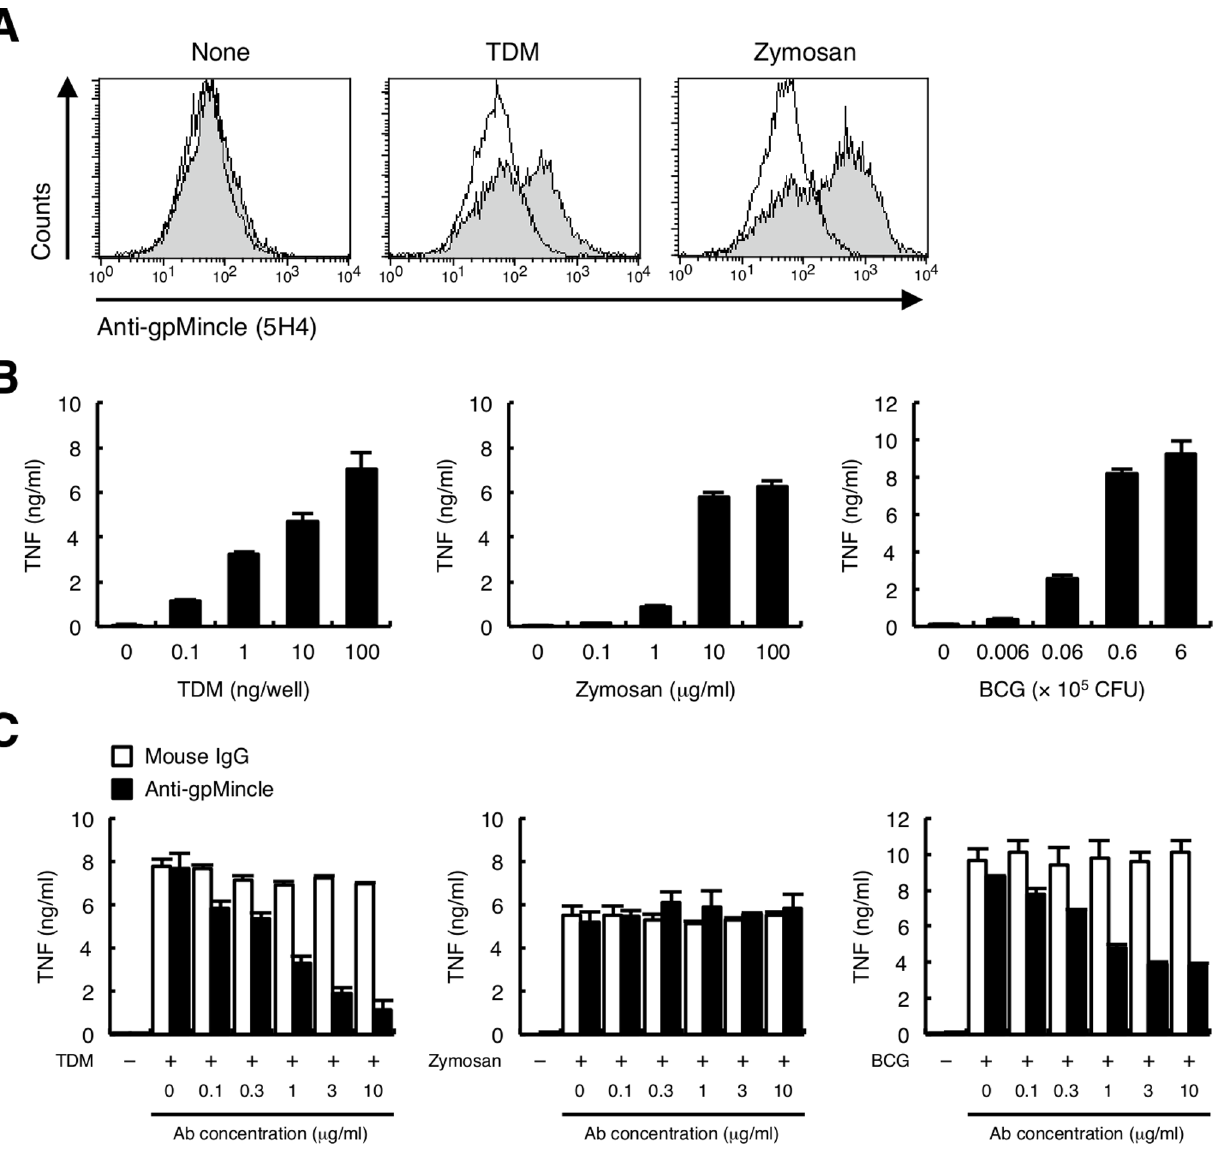
Figure 6. Functional analysis of endogenous gpMincle. (A) Surface expression of gpMincle on macrophage. Macrophages were left untreated (left panel) or stimulated with 10 ng/well TDM (middle panel) or 10 m g/ml zymosan (right panel) for 24 h, and stained with anti-gpMincle mAb (filled histograms) or mouse IgG (open histograms). (B) TNF production upon stimulation. Macrophages were stimulated with TDM (left panel), zymosan (middle panel) or M. bovis BCG (right panel) for 48 h. Concentrations of TNF in the culture supernatants were determined by ELISA. (C) Anti-gpMincle mAb blocks TNF production. Macrophages were stimulated with 100 ng/well TDM (left panel), 10 m g/ml zymosan (middle panel) or 6 6 10 5 CFU M. bovis BCG (right panel) in the presence of anti-gpMincle mAb or mouse IgG for 48 h. Concentrations of TNF in the culture supernatants were determined by ELISA. Data are presented as mean 6 s.d. (B, C) and representative of two or three separate experiments.